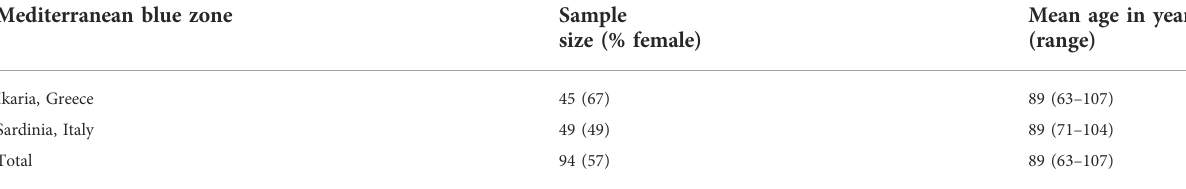
TABLE 1 Age, age range, and number of participants by region and